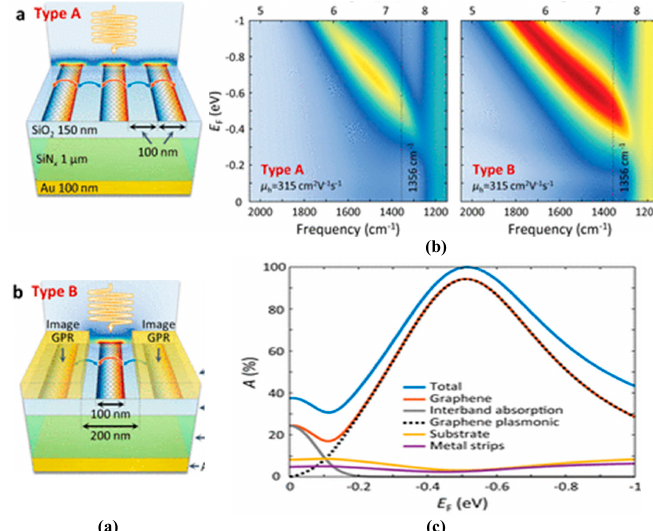
Figure 14. ( a ) Different geometries of graphene plasmonic resonators; ( b ) Mapping of absorption with respect to frequency and Fermi level; ( c ) Absorption tuning considering the different conditions as a function of Fermi energy, as better absorption is achieved at E F = -0.514 cm 2 V − 1 s − 1 . © 2018 ACS. Reprinted with Permission from [166].